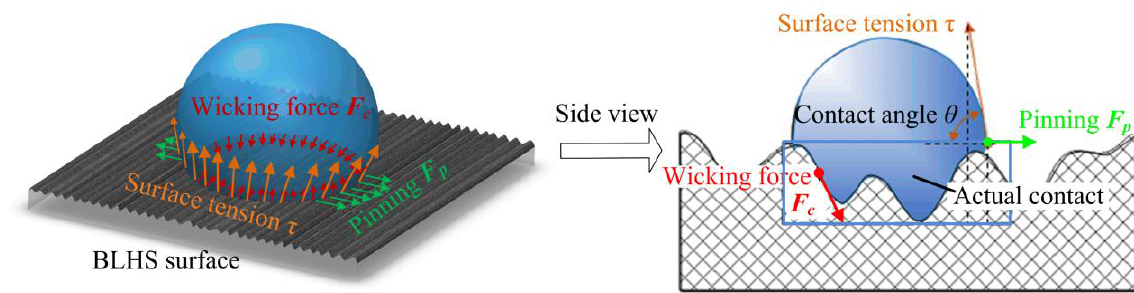
Figure 12. Force analysis of the droplet on the BLHS surface.